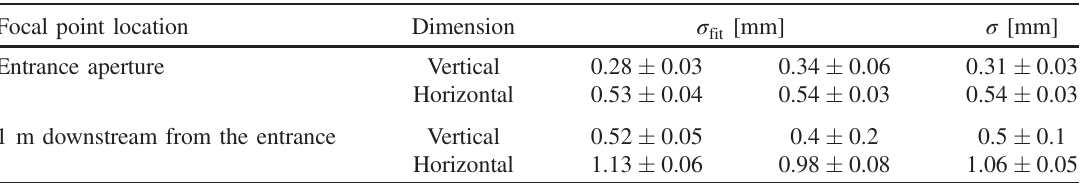
TABLE I. Results of the electron beam scan of the entrance aperture for different focal point locations. Every scan gives two transverse beam size values σ , one for each side of the beam loss signal. The final value of σ is obtained fit as the mean of the two measurements for each scan; the error is calculated propagating the statistical error.